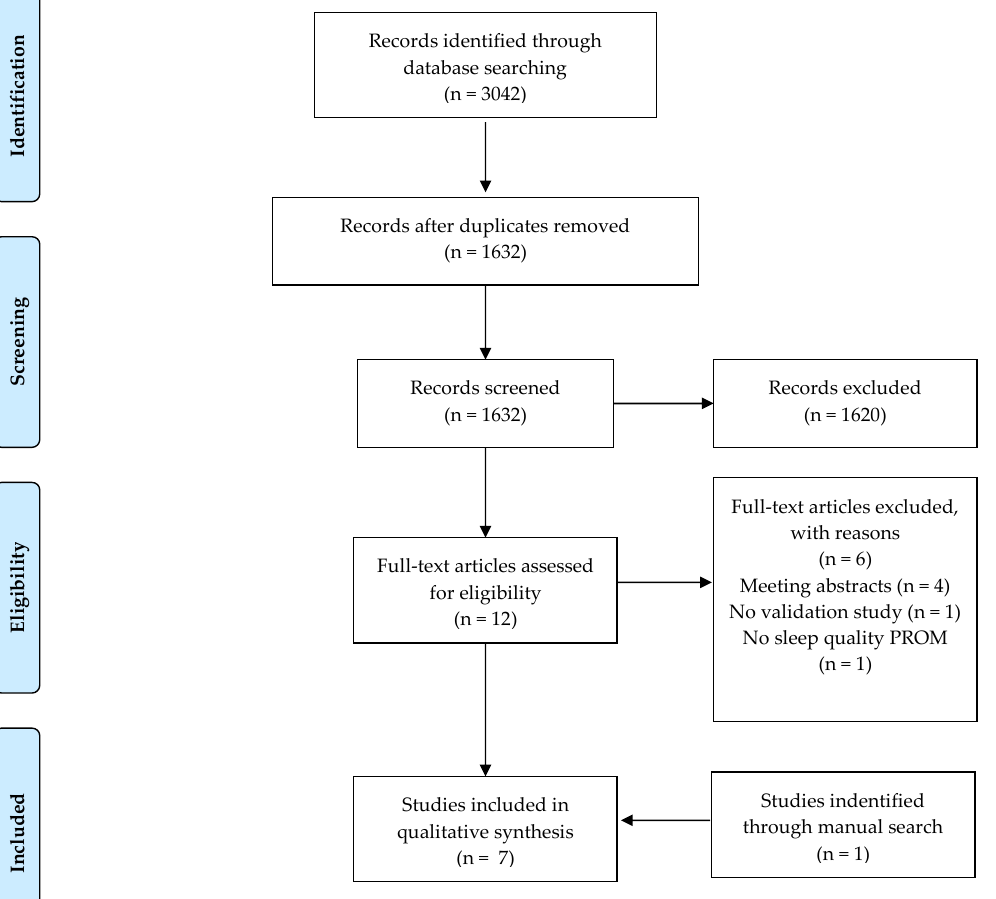
Figure 1. Process of Studies Selection (PRISMA Flow Diagram).